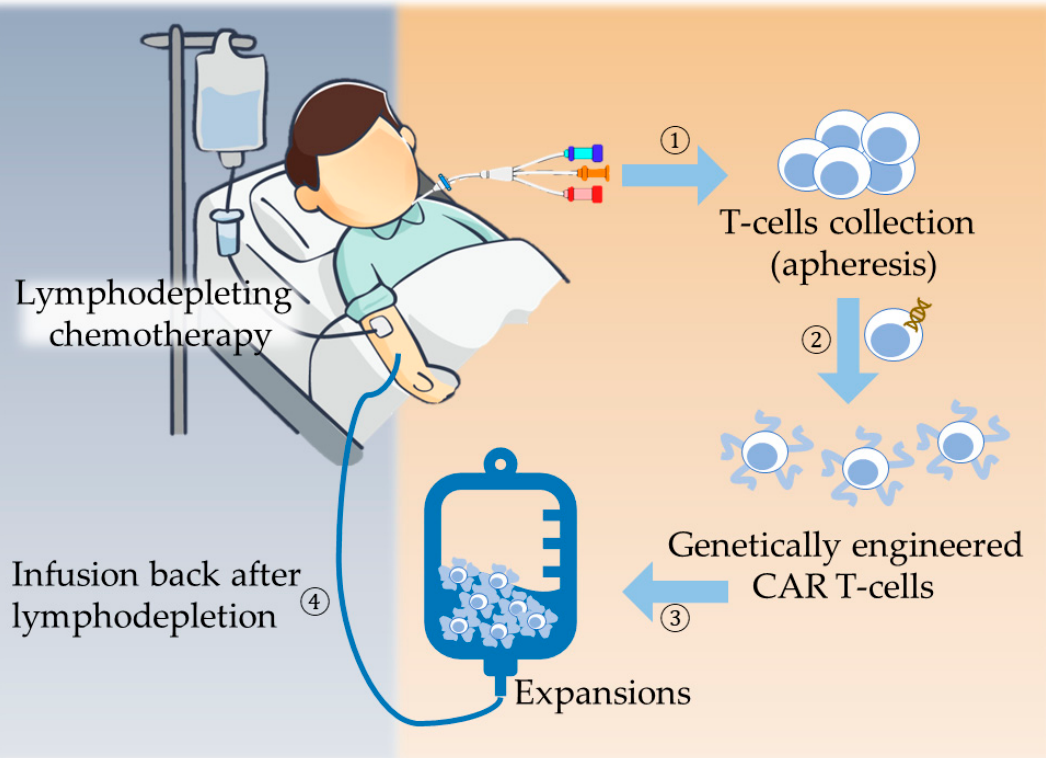
Figure 2. CAR T-cell therapy protocol: (1) T-cell collected from patient’s peripheral blood. (2) Artificial antigen and costimulatory domains are engineered into T-cells. (3) Amplification of CAR T-cells to